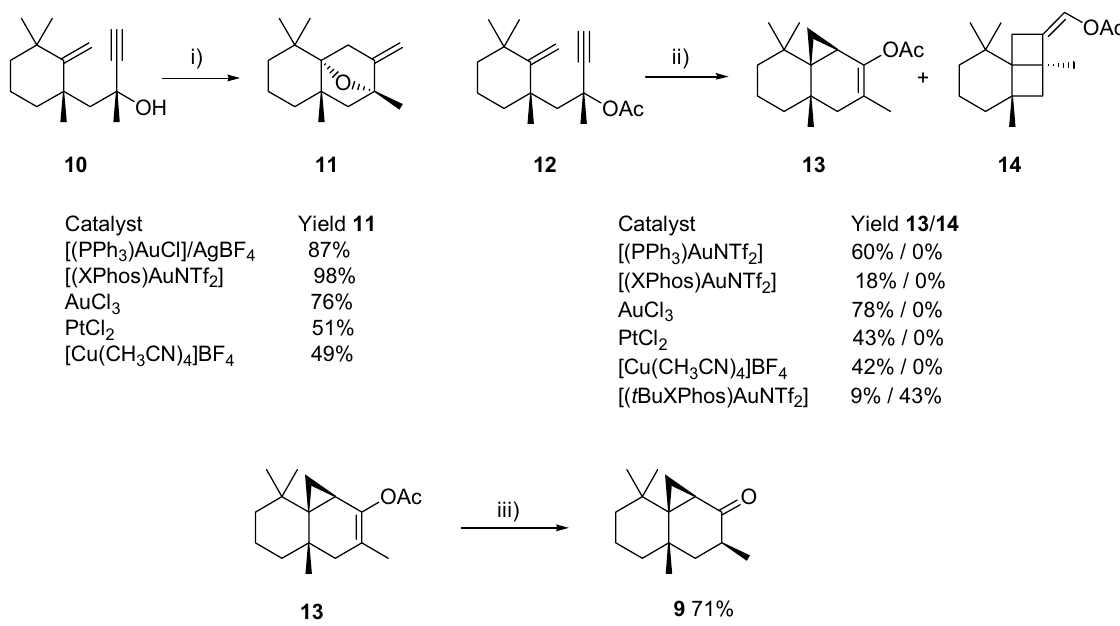
Scheme 5. Cycloisomerization of enynol 10 and [1,2]-acyl shift rearrangement of acetate 12 , respectively.